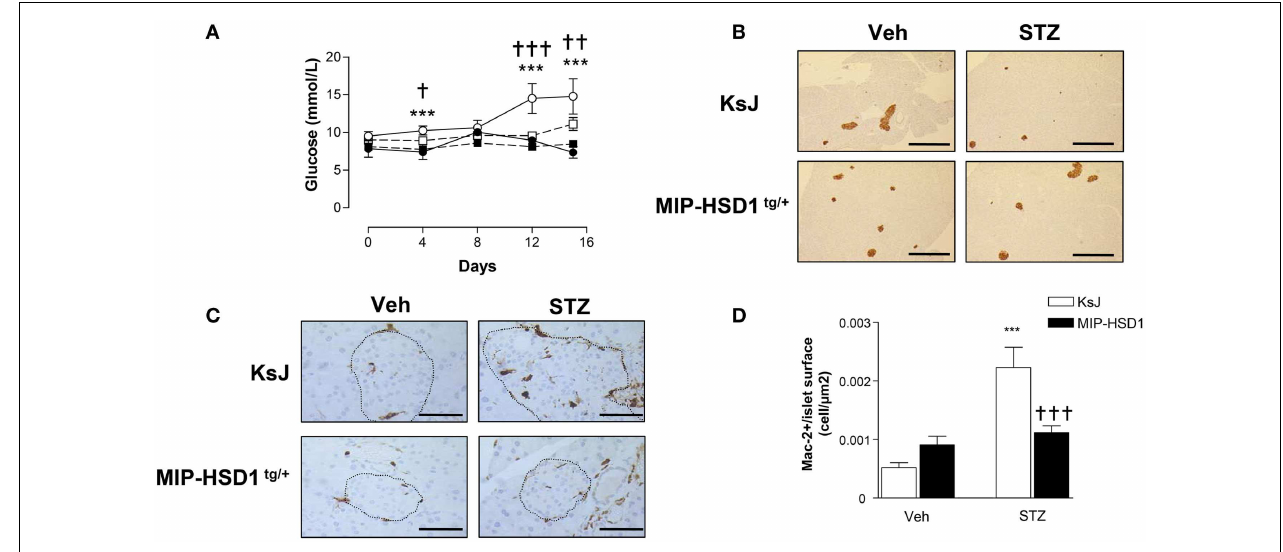
(B) Preservation of islet structure in MIP-HSD1 tg/ + shown by insulin staining of paraffin-fixed pancreata from KsJ mice (upper row) and MIP-HSD1 tg/ + mice (bottom row) 10days after the end of vehicle (Veh, left lane) or STZ (right lane) treatment. Scale = 400 µ m magnification × 50. (C) Reduced macrophage infiltration in MIP-HSD1 tg/ + shown by Mac-2 staining of paraffin-fixed pancreata from KsJ mice (upper row) and MIP-HSD1 tg/ + mice (bottom row) 10days after the end of vehicle (Veh, left lane) or STZ (right lane) treatment. Bars = 50 µ m, magnification × 400. (D) Quantitation of Mac-2 positive cells per islet area using Zeiss (KS300, 3.0) software.Values represent mean ± SEM, differences were analyzed by one-way ANOVA, Newman–Keuls test, *** P < 0.001 for STZ vs.Veh; *** P < 0.001 for MIP-HSD1 tg/ + STZ vs. KsJ STZ ( n =